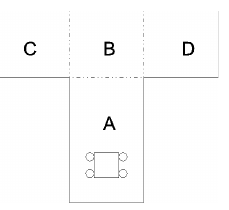
Figure 3. Buildingplacecellsduringexplorationoftheenvironment. Theknownportionoftheenvironmentat t to share a common color.